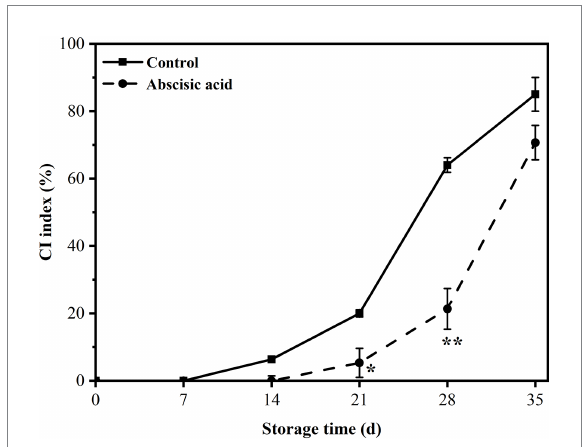
FIGURE 1 Effect of abscisic acid (ABA) treatment on chilling injury index of peach fruit during cold storage at 4 ° C. Vertical bars represent the standard deviation of the means of triplicate samples ( n = 3). The symbol (*) indicates significant differences among different treatments at p < 0.05. The symbol ( ** ) indicates significant differences among different treatments at p <